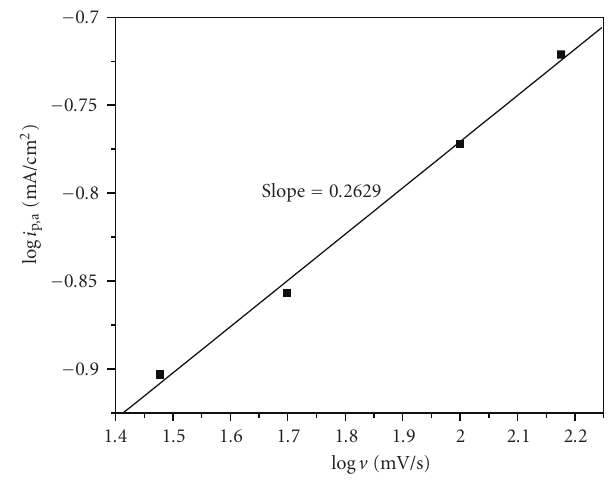
Figure 5: Plot of log i p,a versus log v for